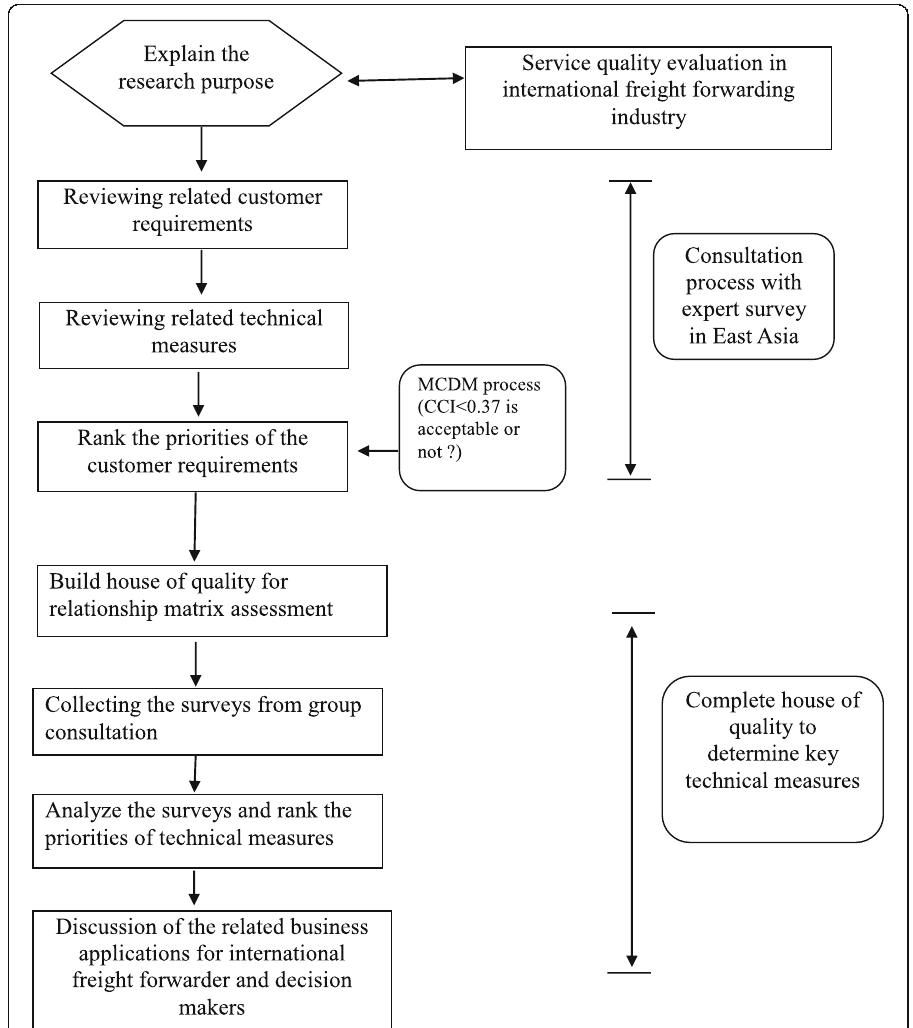
Fig. 1 Method application design for service quality evaluation in international freight forwarding